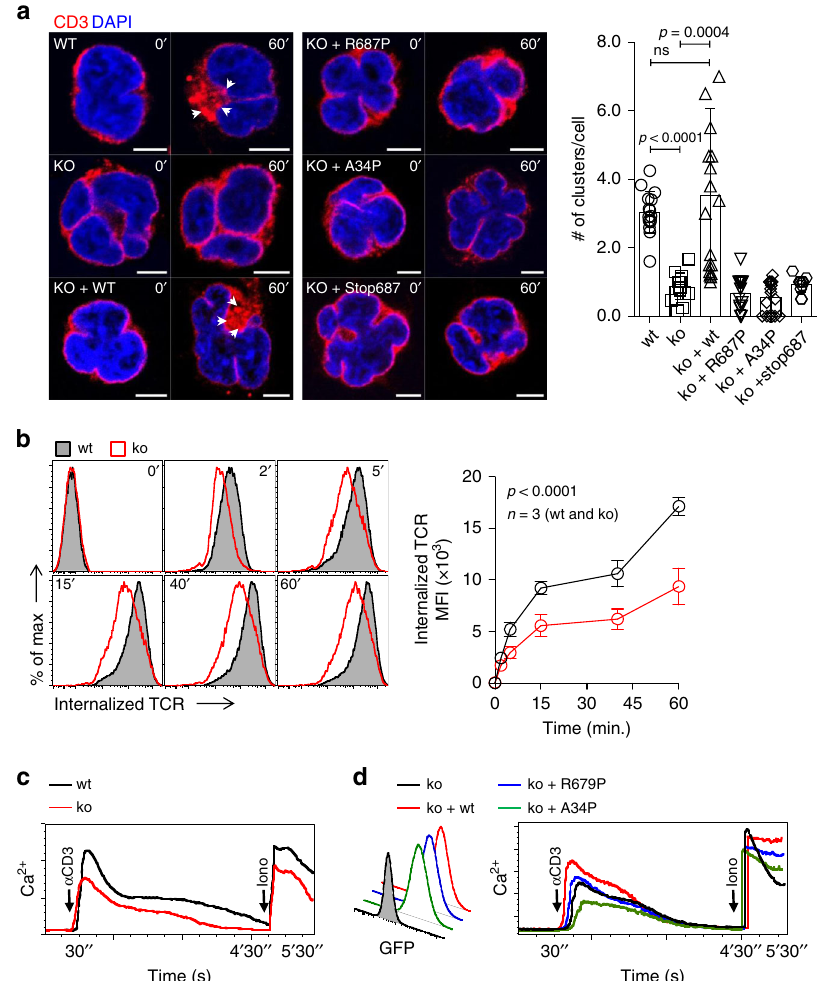
HIV-1 pseudotypes can be quanti fi ed by intracellular staining for HIV-1 p24 antigen 32 . Jurkat wt and FCHO1 ko clones were challenged with different multiplicities of infection of either VSV-G HIV-1 Δ Env (BlaM- Vpr) (Fig. 5a and Supplementary Fig. 10a) or VSV-G HIV-1 Δ Env (Fig. 5b and Supplementary Fig. 10b). FCHO1-de fi cient Jurkat T clones displayed a susceptibility to VSV-G pseudotyped